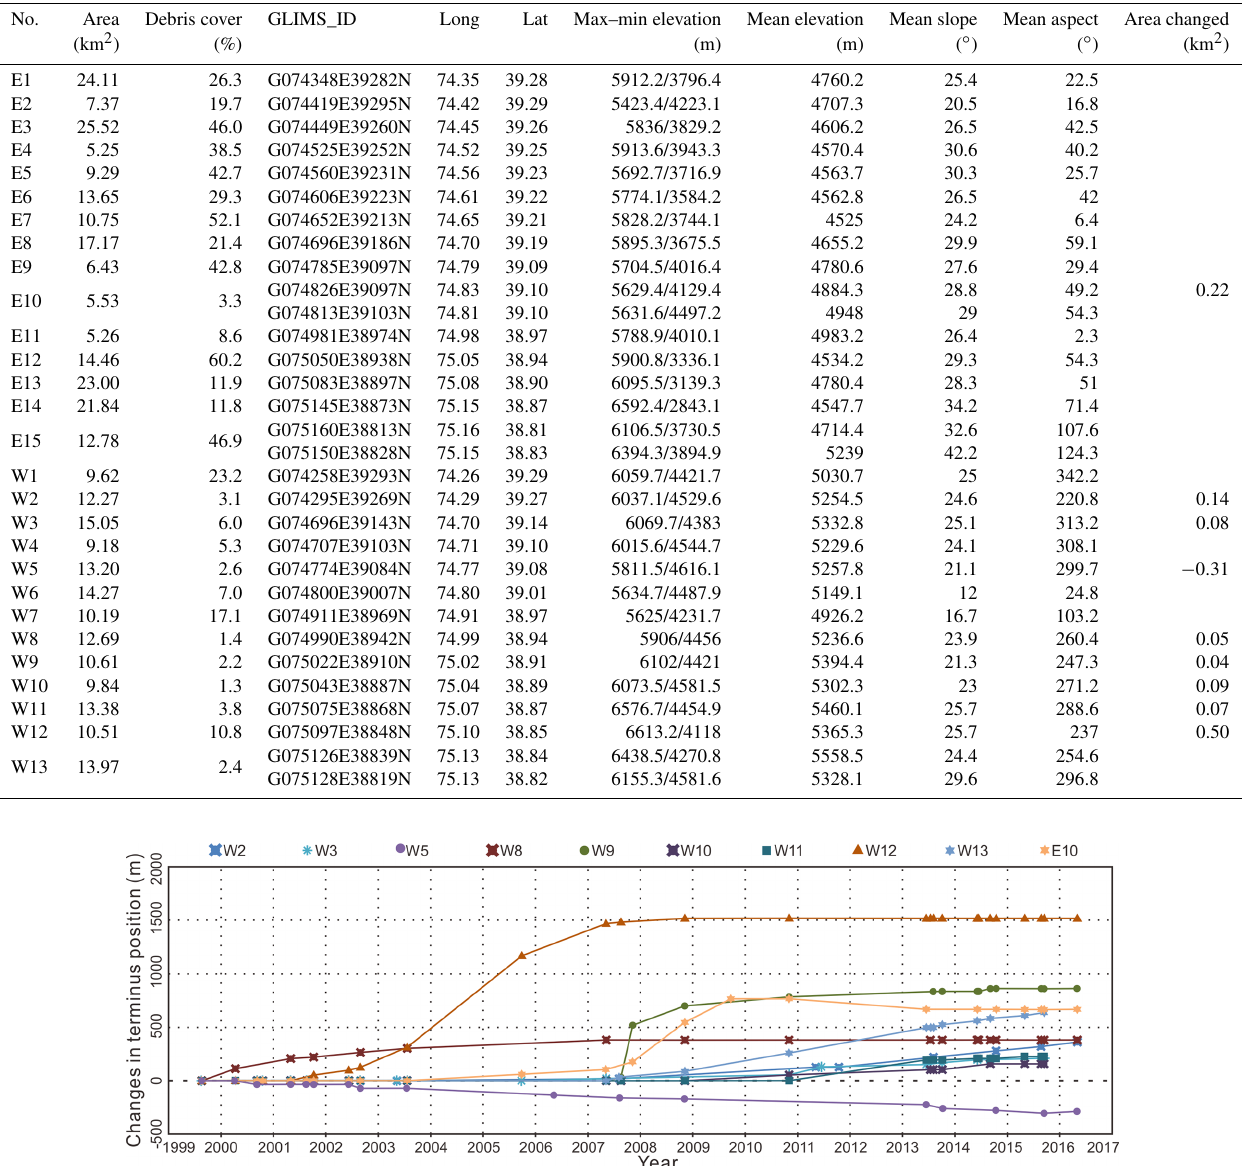
Table 1. Attributes of the glaciers in this study. Glacier area and percentage of debris cover are measured based on images in 2016. Values relating to areal changes were measured from 1999 to 2016. E10, E15, and W13 are composite glaciers as recorded in the Second Glacier Inventory Dataset of China.